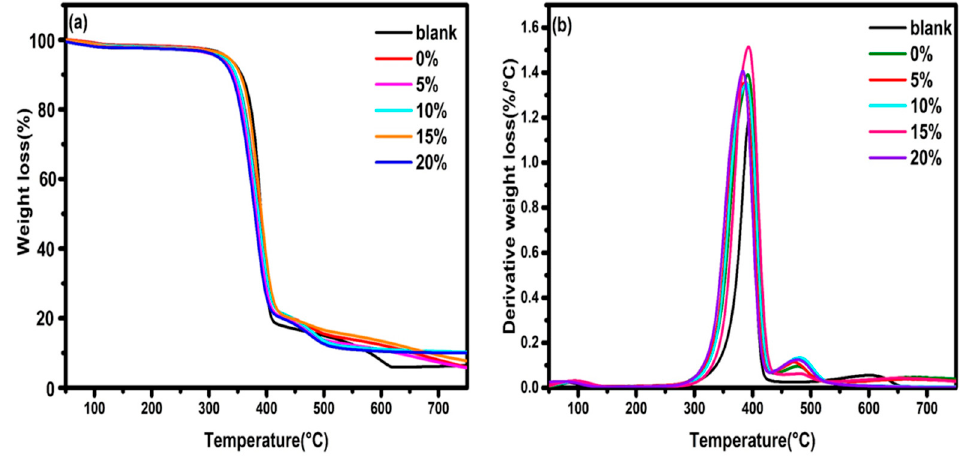
Figure 7. The thermogravimetric analysis (TGA) and the derivative thermogravimetric analysis (DTGA) of the blank paper and papers coated with PVAc and its lignin copolymers containing different fractions of